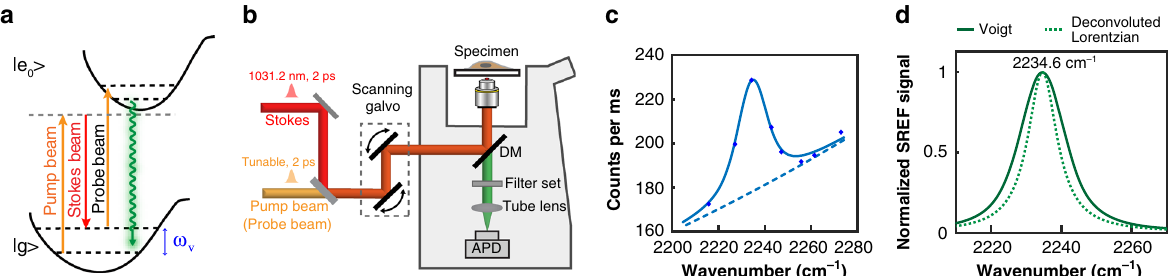
Fig. 1 SREF microscopy. a Energy diagram for SREF process. b Microscope setup for SREF imaging. c SREF spectrum of 5- μ M Rh800 in DMSO. SREF spectrum (solid line) is fi tted with a sum of Voigt shape with an exponential decay background (dashed line). d Normalized SREF peak as Voigt shape (solid line) and Lorentzian shape after laser broadening deconvolution (dashed